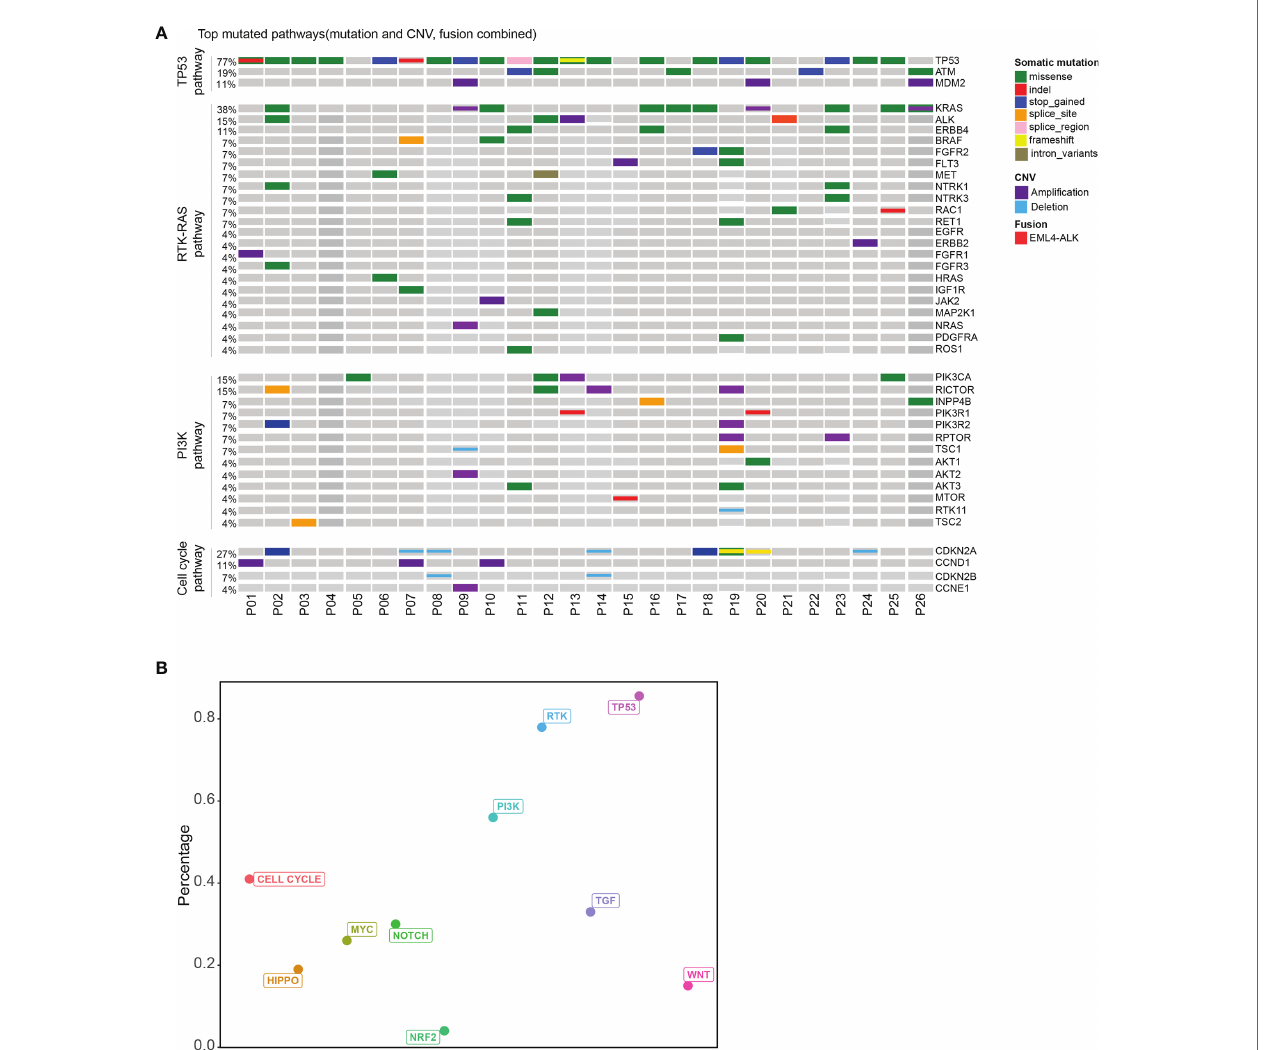
FIGURE 2 | Pathway analysis of patients with unknown primary tumor. (A) Top mutated canonical pathways in the CUP cohort. The mutation types were indicated by the color on the right. Each column represents one patient. (B) The percentage of patients with different altered canonical pathways. Distribution of patients with mutated HRR